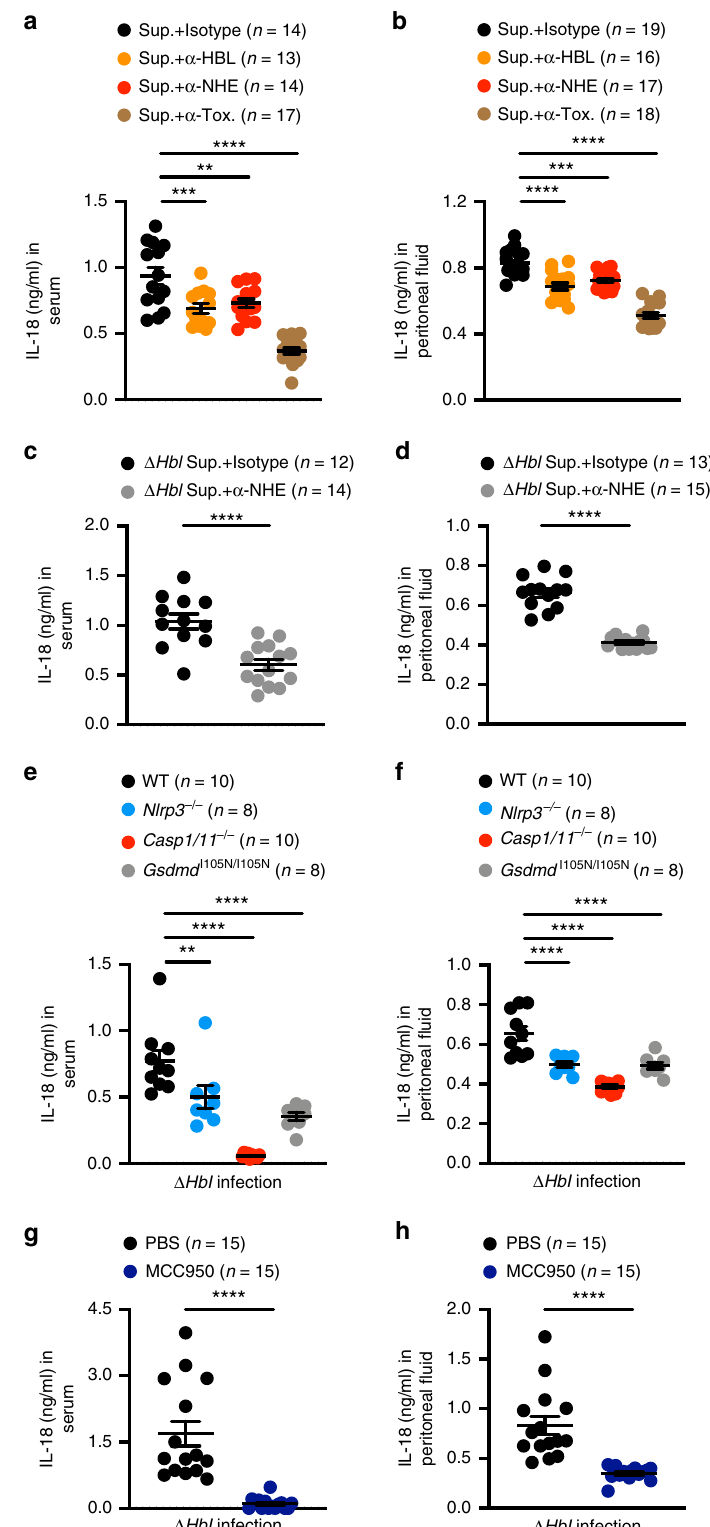
and 1% penicillin and streptomycin. CT26, Jurkat, RMA-S, and THP-1 cells were cultured for 3 days in Rosewell Park Memorial Institute (RPMI)-1640 (11875093, ThermoFisher Scienti fi c) supplemented with 10% FBS, and 1% penicillin and strep- tomycin. HEK293T and HT-29 cells were cultured for 3 days in DMEM supple- mented with 10% FBS, and 1% penicillin and streptomycin. L929, LS 174T, MDCK, and Vero cells were cultured for 3 days in EMEM supplemented with 10% FBS,